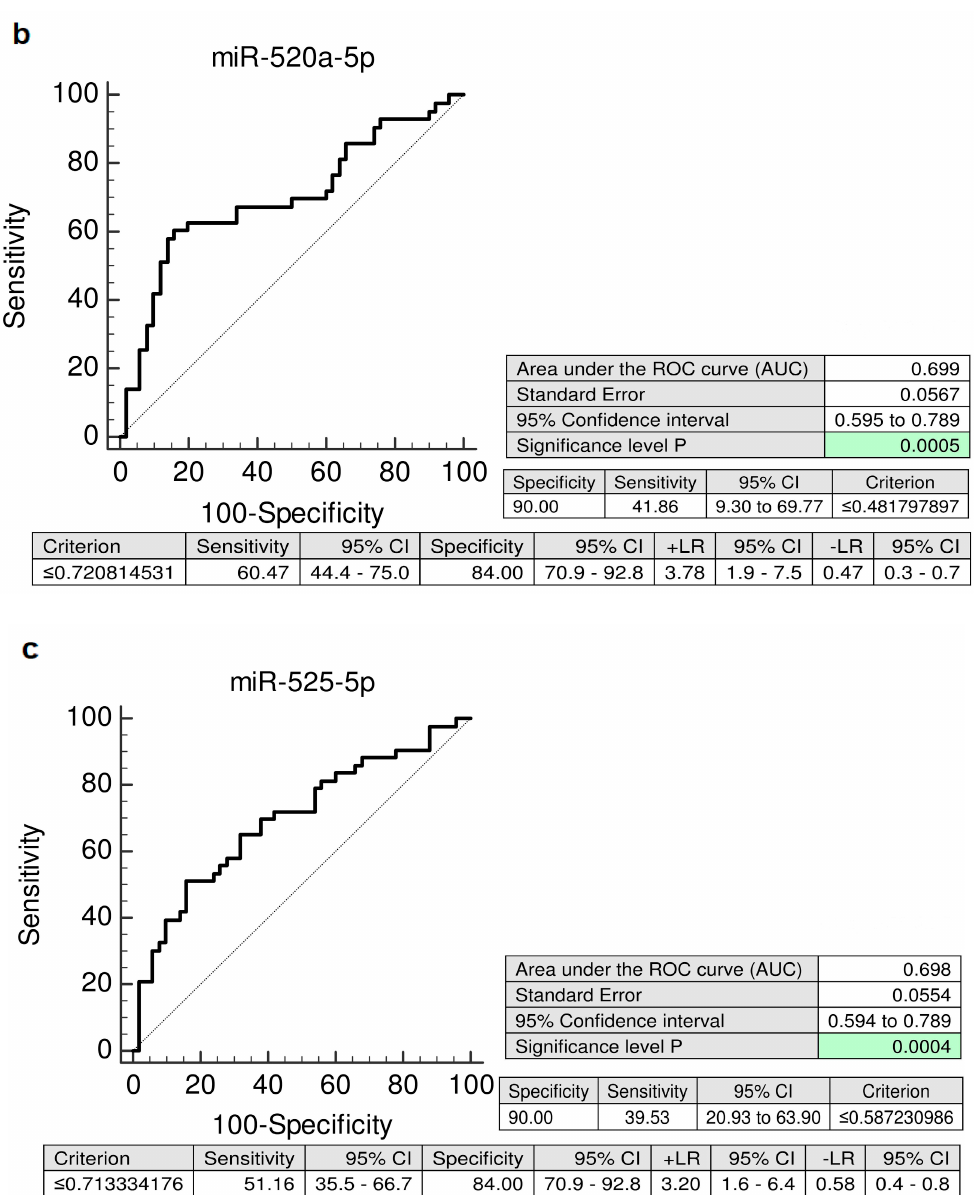
Figure 4. ROC curves—individual C19MC microRNA biomarkers—evaluation of the potential of the first trimester C19MC microRNA screening in plasma exosomes to predict subsequent onset of PE. Decreased levels of miR-517-5p, miR-520a-5p, and miR-525-5p were detected in women destinated to develop PE when the comparison to the controls was performed ( a – c ). PE: preeclampsia. The combined screening of miR-517-5p, miR-520a-5p, and miR-525-5p was superior over using individual C19MC microRNA biomarkers or their dual combinations, since it was able to predict the highest number of women with the subsequent onset of PE (AUC 0.719, p < 0.001, 44.19% sensitivity at 10.0% FPR) (Figure